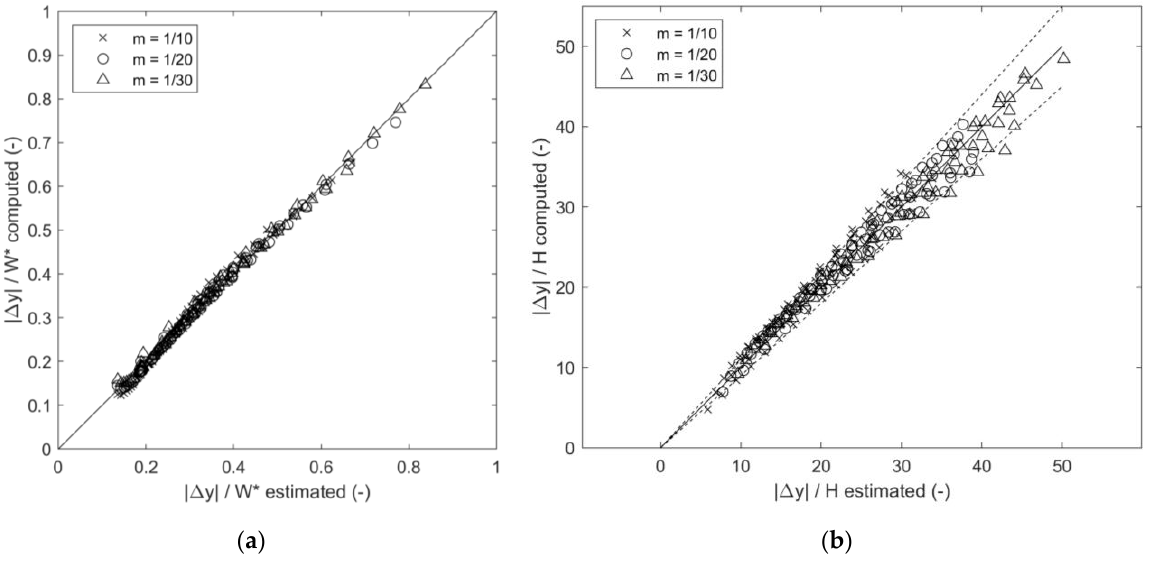
Figure 6. Results of the dimensionless beach profile erosion obtained with the model with respect to Equation (14) ( r 2 = 0.993; panel ( a )) and Equation (17) ( r 2 = 0.970; panel ( b )).